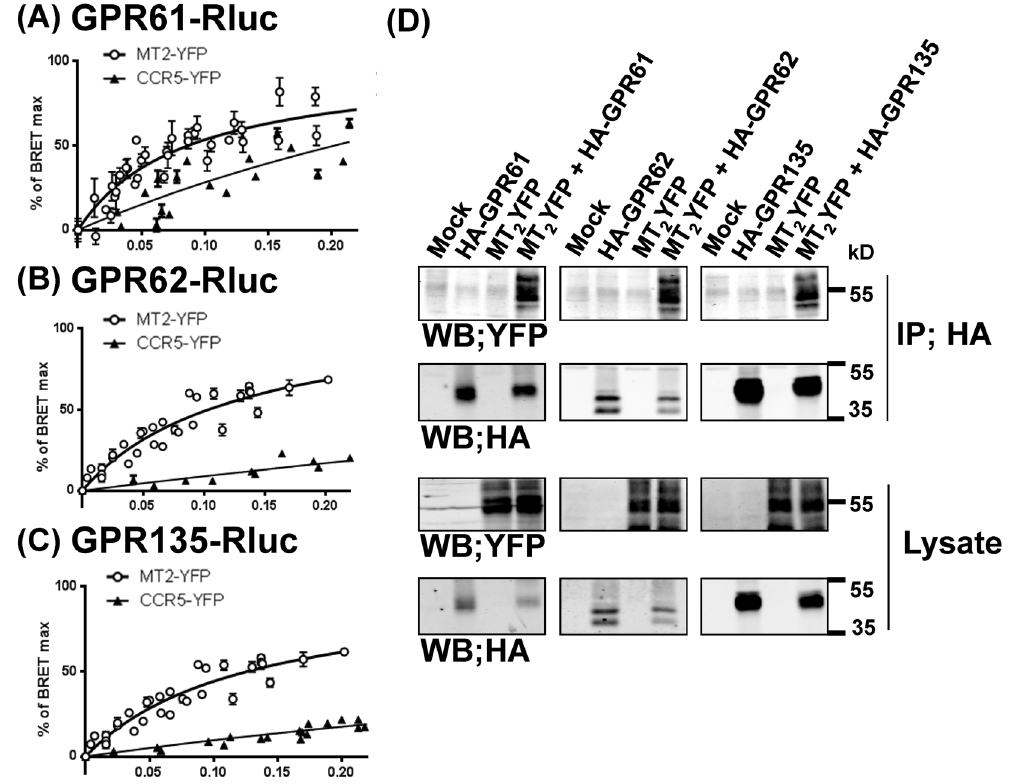
Figure 6. Heteromer formation of MT 2 with GPR61, GPR62 and GPR135 in living HEK 293 T cells. ( A–C ) BRET donor saturation curves were generated by expressing constant amounts of GPR61-Rluc ( A ), GPR62-Rluc ( B ) and GPR135-Rluc ( C ) fusion proteins (energy donor) and increasing quantities of the indicated YFP-tagged receptors (energy acceptor) in HEK293T cells. The curves represent at least 3 individual saturation curves. Curves were normalized to BRET max values. Curves obtained for the BRET acceptors MT 2 -YFP were best fitted with a nonlinear regression equation assuming a single binding site, those obtained for CCR5-YFP were best fitted with a linear regression equation. ( D ) Co-immunoprecipitation of MT 2 /GPR61 (left), MT 2 /GPR62 (middle) and MT 2 /GPR135 (right) heteromers. Lysates from HEK293T cells expressing the indicated receptors were immunoprecipitated (IP) with anti-HA antibodies, and the presence of co-precipitated MT 2 -YFP was detected with anti-GFP antibodies (upper Western blot (WB)). Expression of fusion proteins in lysates was assessed by immunoblotting with the indicated antibodies (lower Western blots). Data are representative of three